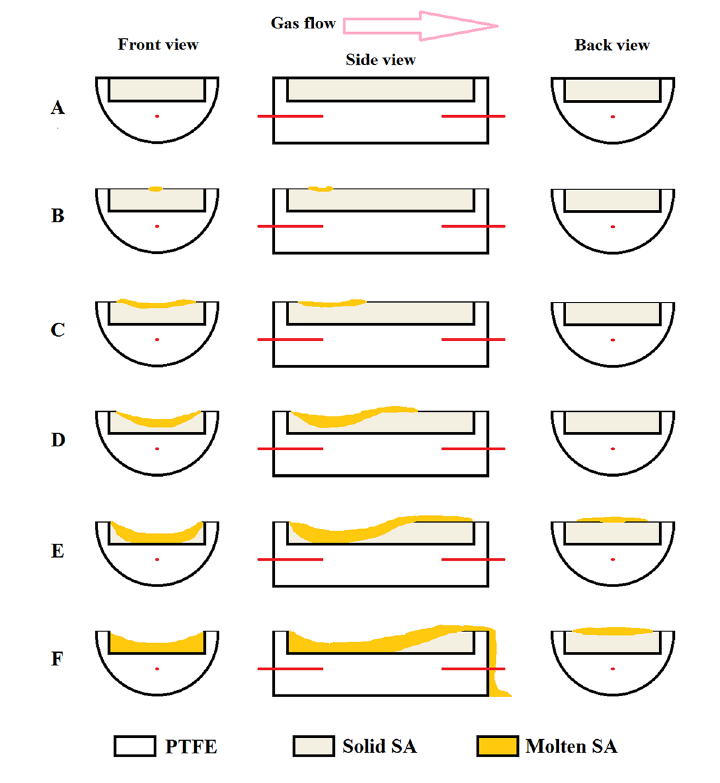
Figure 6. Schematic profile of sample during experiment. The red line represents the thermocouple and the letters represent different moments of